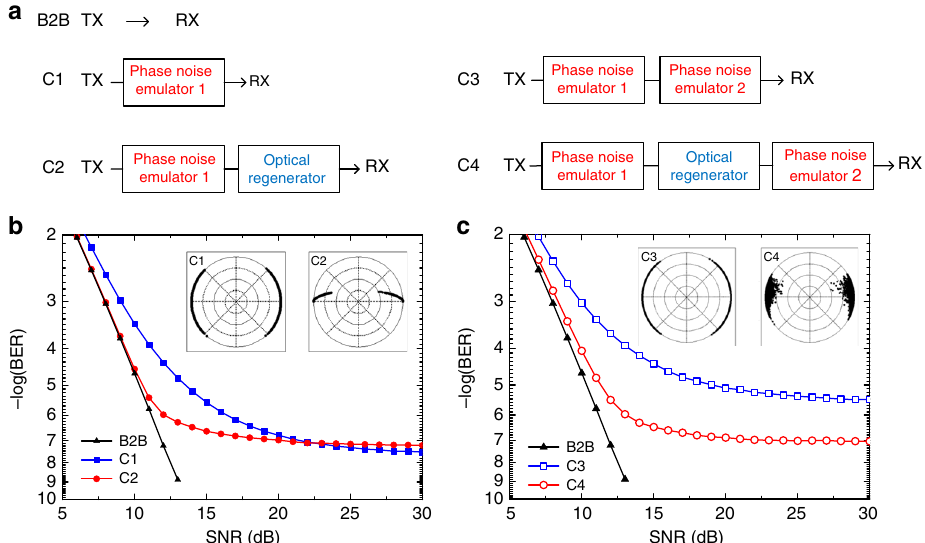
Fig. 4 Simulation analysis of positioning an optical phase regenerator. a Four different simulation scenarios, (C1) single noise emulator between the transmitter (TX) and the receiver (RX), (C2) single noise emulator followed by an optical phase regenerator, (C3) dual noise emulator, (C4) dual noise emulator separated by an optical phase regenerator. b Simulated BER and constellation diagram of scenarios (C1) and (C2). c Simulated BER and constellation diagram of scenarios (C3) and